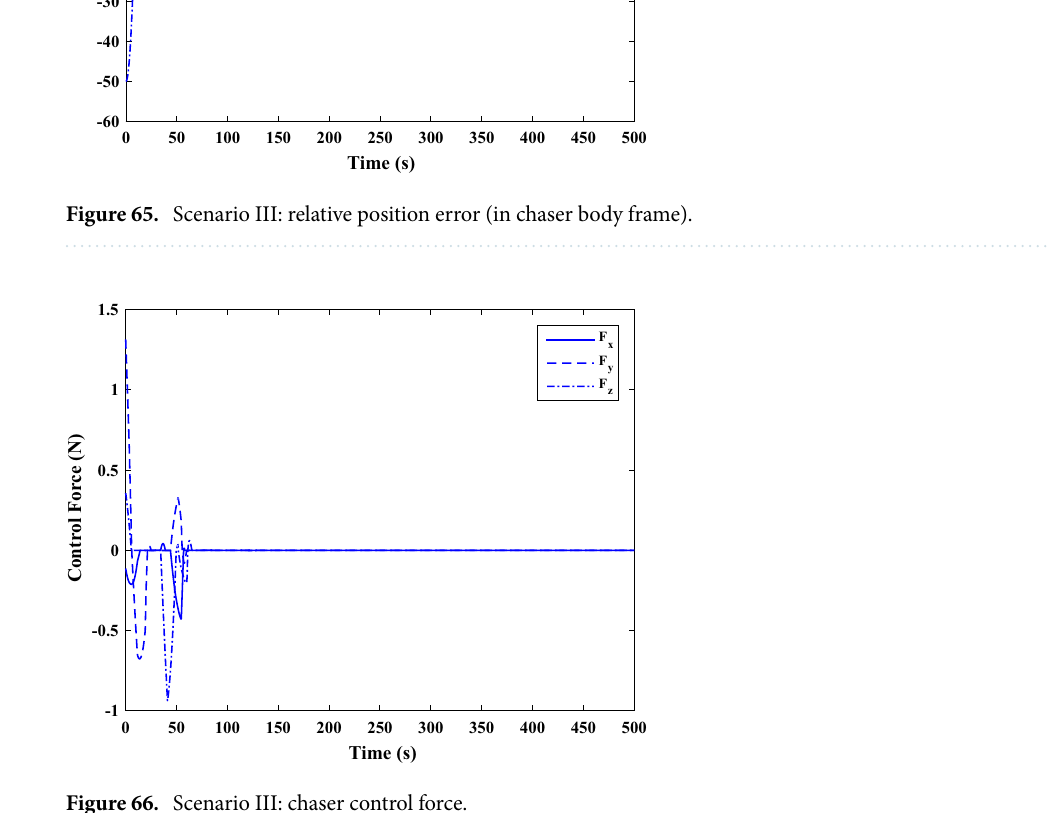
Figure 66. Scenario III: chaser control